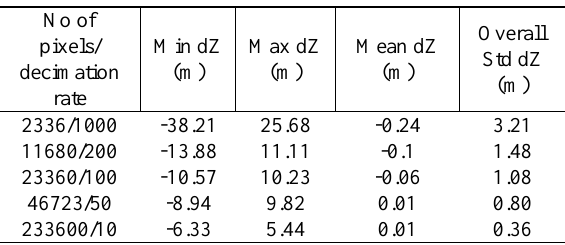
Table 2. Results of the comparison of the decimated DTMs vs.